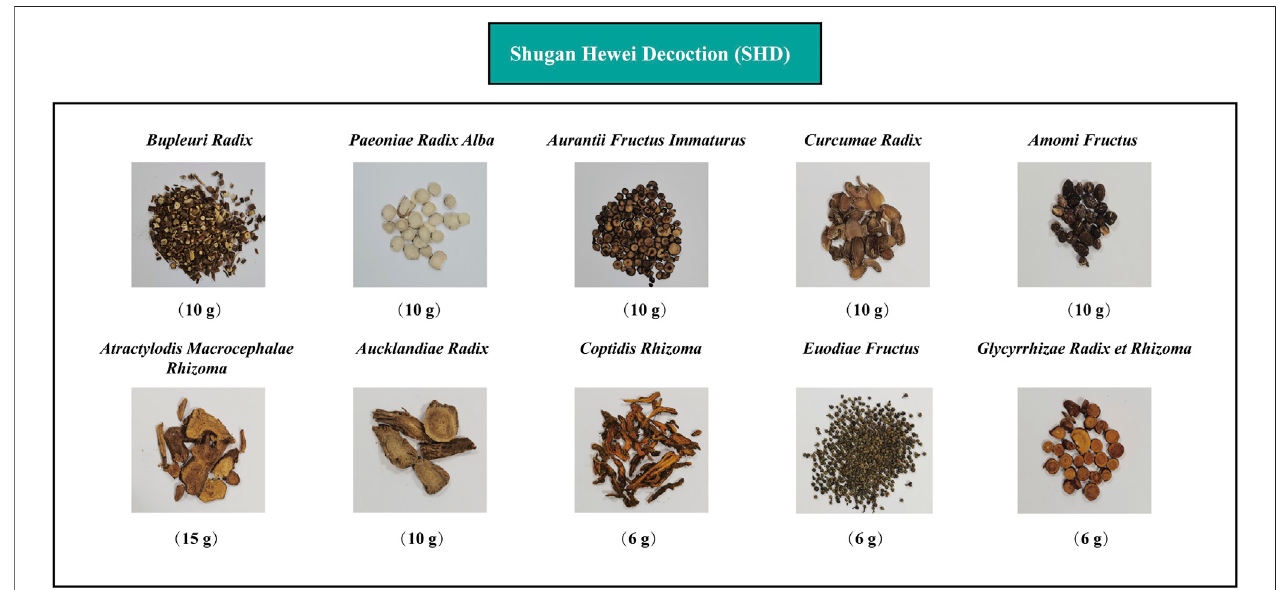
FIGURE 1 | Chinese herbs formula of Shugan Hewei Decoction